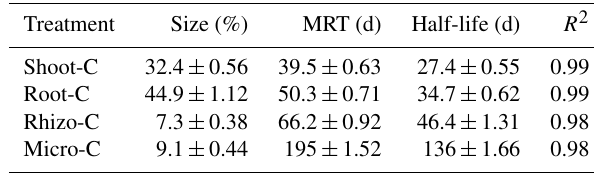
Figure 1. 13 CO 2 (a) and 13 CH 4 (b) efflux per day over the 300- day incubation period. Values and error bars represent mean % ini- tial 13 C ± SE ( n = 4). Shoot-C, unlabelled paddy soil supplemented with 13 C-labelled shoot residue; root-C, unlabelled paddy soil sup- plemented with 13 C-labelled root residue; rhizo-C, paddy soil con- taining 13 C-labelled rhizodeposits; micro-C, paddy soil containing 13 C-labelled microbe-accumulated C.